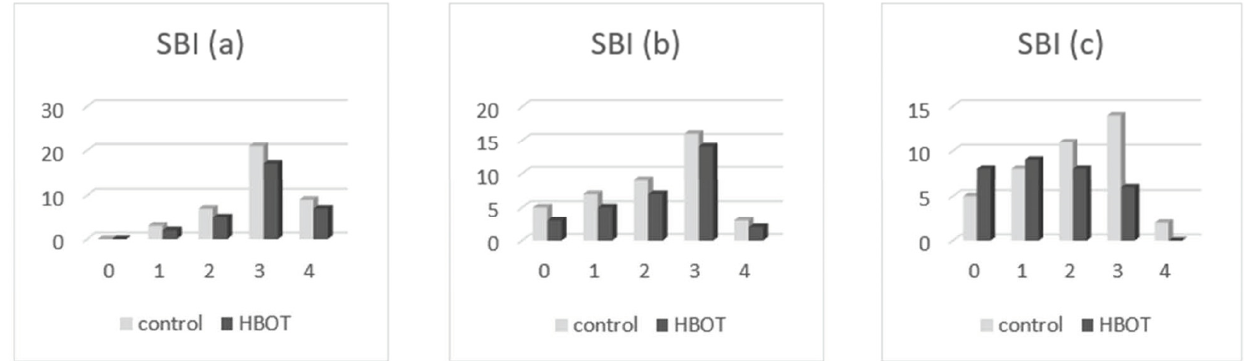
Figure 5. Patient distribution based on SB index at ( a ) first examination, ( b ) second examination, and ( c ) third examination.